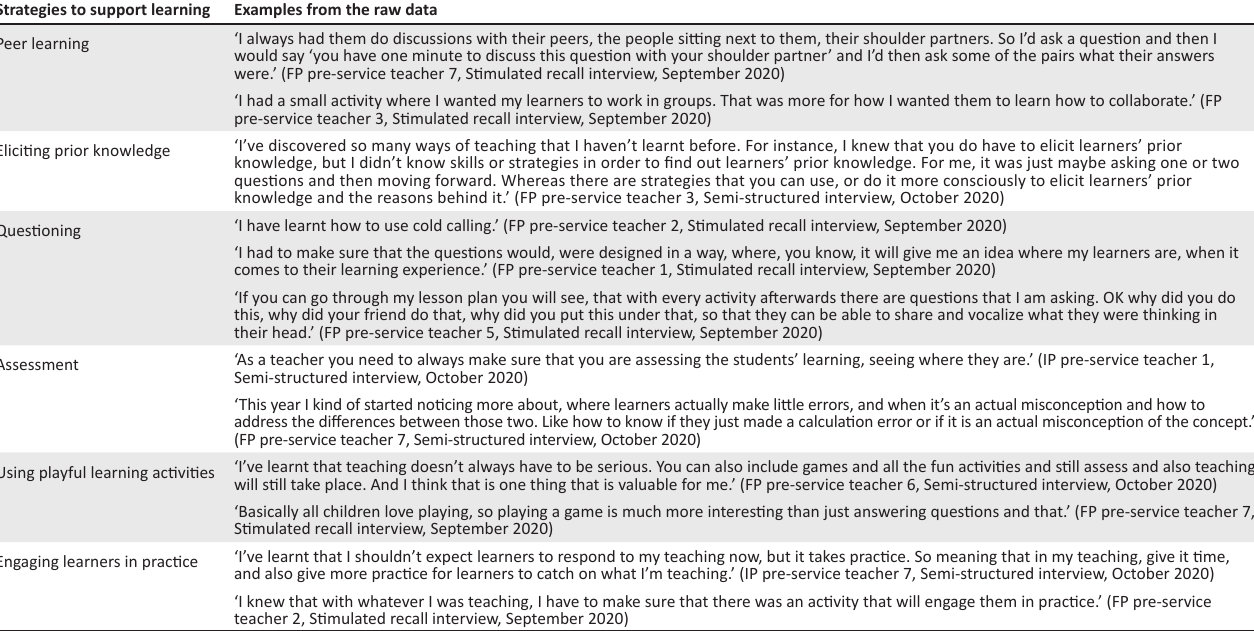
TABLE 1: Strategies learned (and valued) by the pre-service teachers that could support learning. Strategies to support learning Examples from the raw data Peer